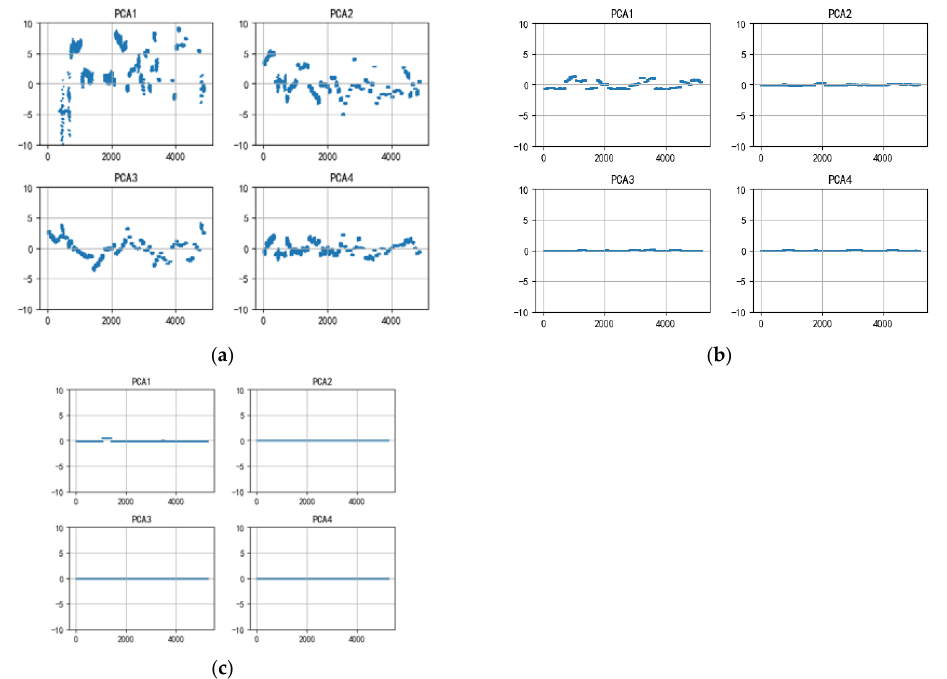
Figure 12. ( a ) The first 4 principal component distributions of the reconstructed XAS under FBP and ART ( b ) as well as ML-EM ( c )